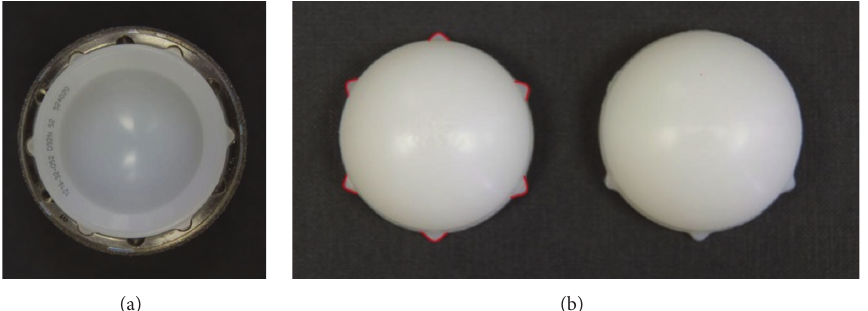
Figure 4: (a) Demonstrates shell Anti-Rotation Device (ARD) scallops which accept liner ARD tabs to enhance locking mechanism stability. (b) Normal appearance of polyethylene liner (6 ARD tabs highlighted in red) versus abnormal polyethylene liner in liner dissociation (failure of multiple ARD